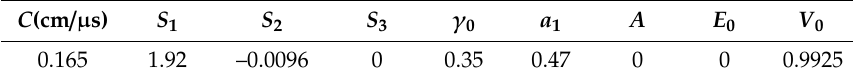
Table 2. Water parameters of the Gruneisen state